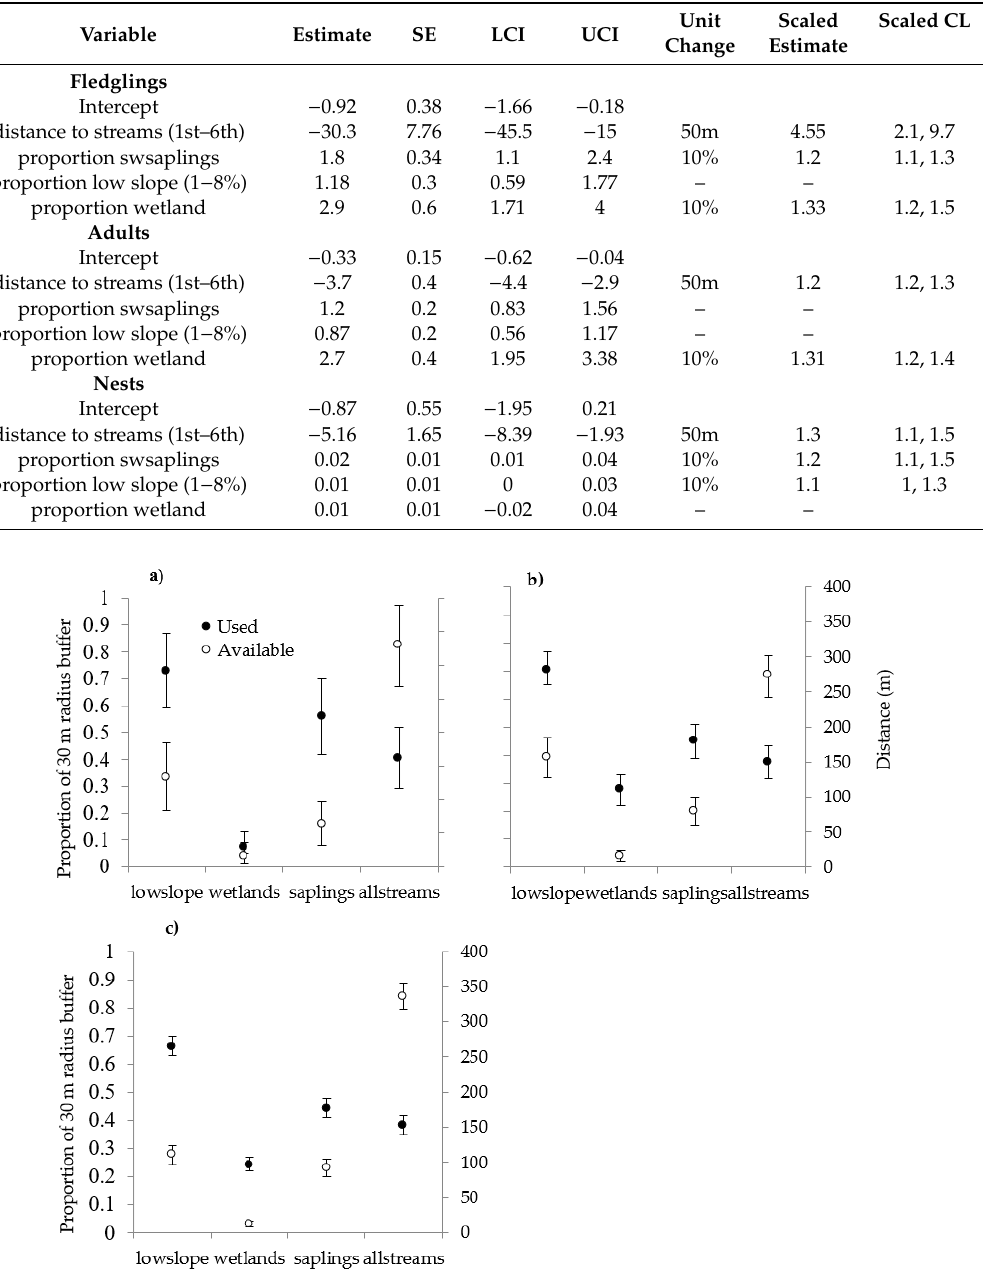
Figure 2. Mean and 95% CI of variables from top models of ( a ) nest use (black circles; n = 37) relative to availability (white circles; n = 57), ( b ) fledgling habitat use (black circles; n = 198) relative to availability (white circles; n = 196), and ( c ) adult use (black circles; n = 537) relative to availability (white circles; n = 609) in N. New Hampshire from 2010–2012. Proportion of lowslope, wetlands, and softwood / mixed-wood saplings are on the left y -axis, and distance (m) of points from allstreams is on the right x -axis. Lowslope = % of 30 m bu ff er in soil class poorly or very poorly drained, wetlands = % of 30 m bu ff er in any vegetated palustrine wetland, saplings = % of 30 m bu ff er in softwood / mixed-wood sapling stands, and allstreams = mean distance of bu ff er to 1st–6th order